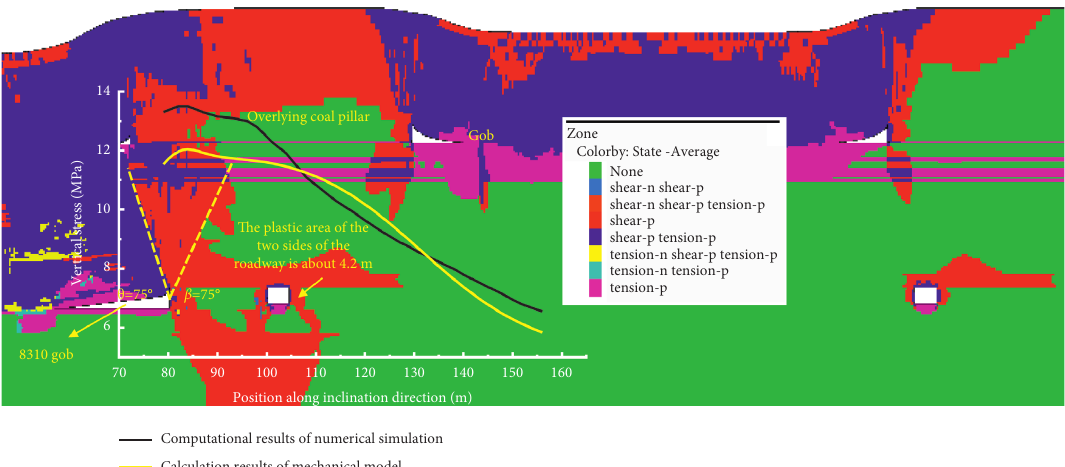
Zone Colorby: State -Average None